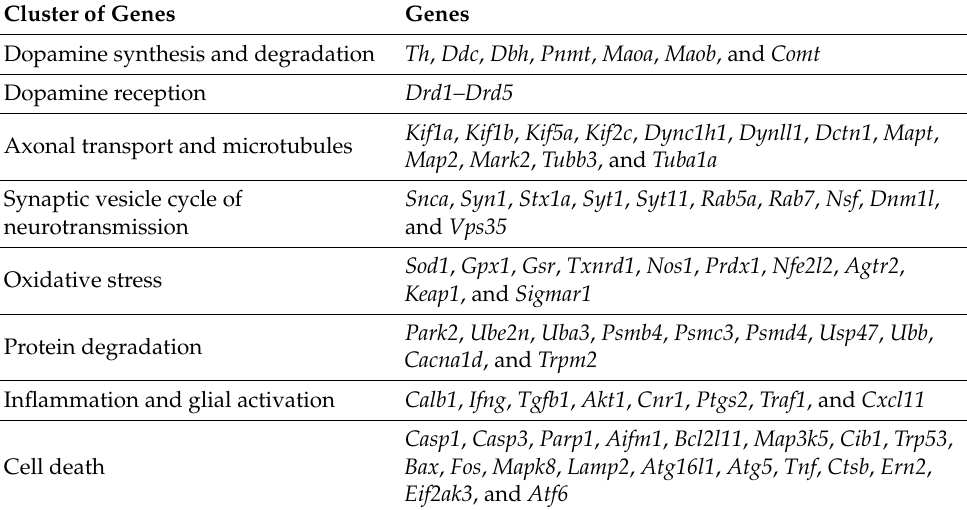
Table 5. List of genes presented on chips produced by Thermo Fisher Scientific for RT PCR with Open Array Technology and clustered by protein